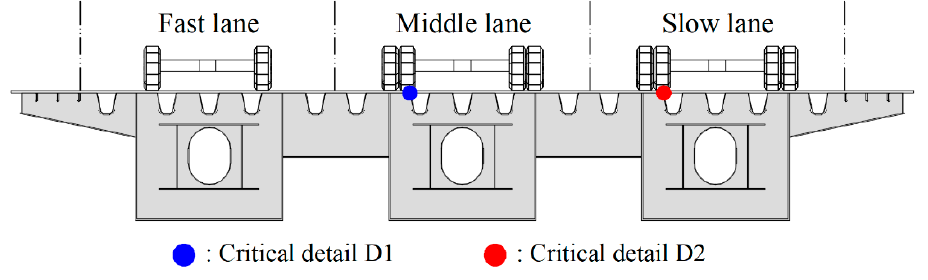
Figure 10. Sectional view of the prototype bridge.